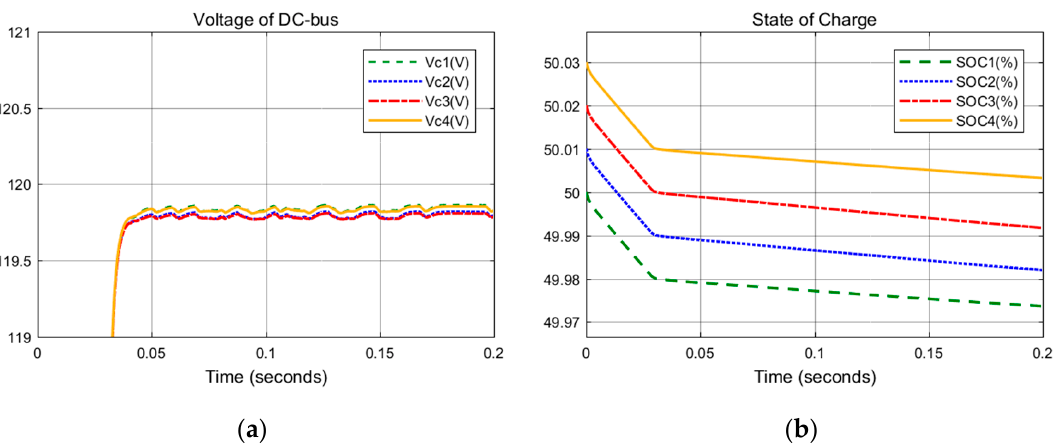
Figure 8. Only with the primary control of multiple DCESs: ( a ) DC-bus voltage; ( b ) battery